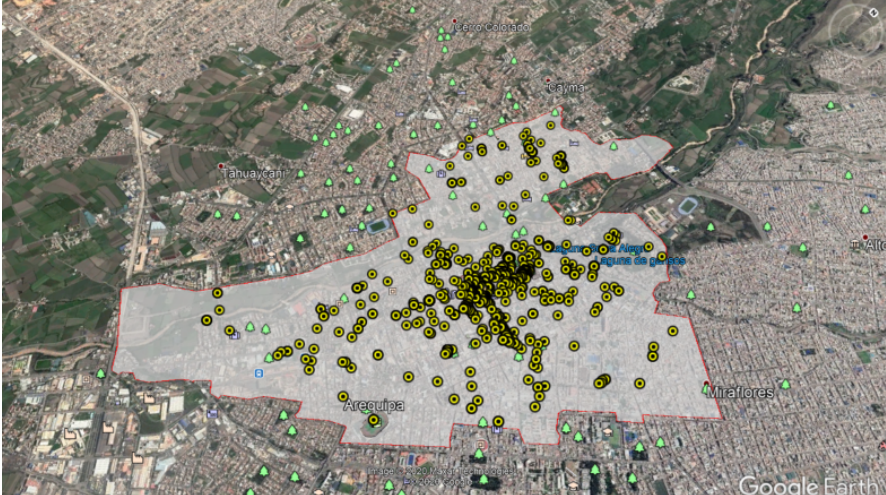
Figure 3. Data located in the historical center.